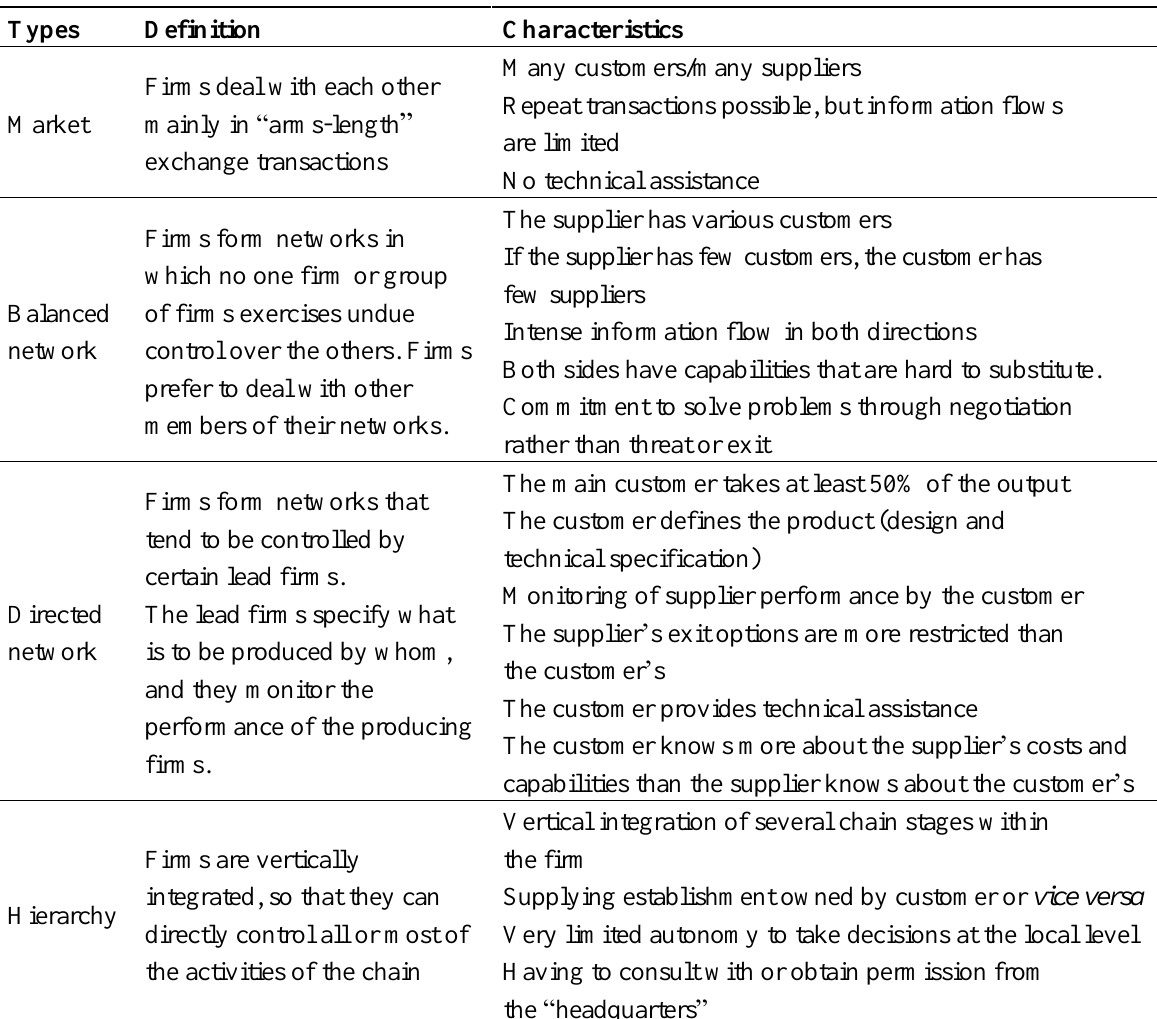
Table 3. Types of governance in the value chain